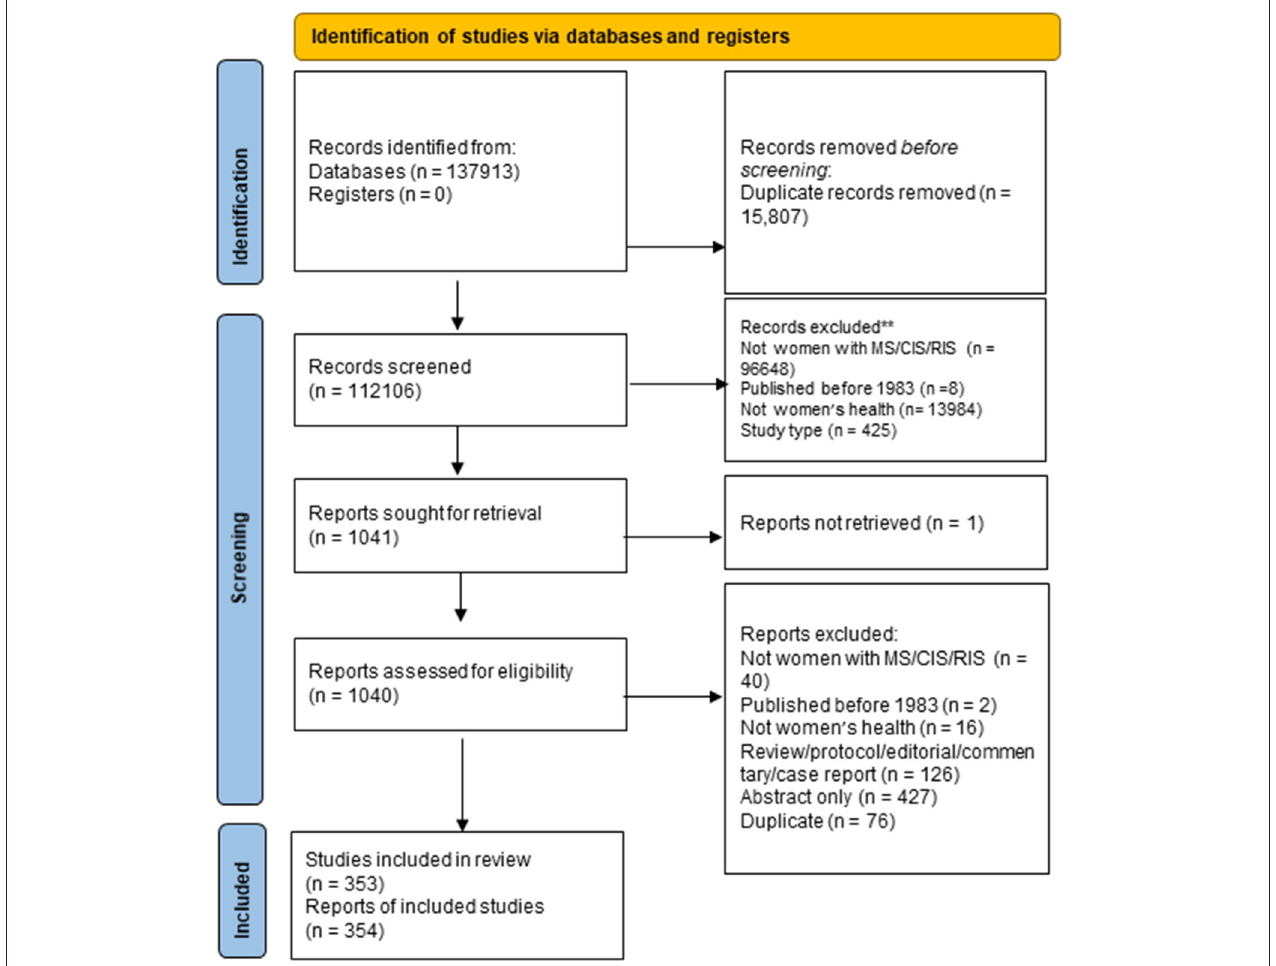
FIGURE 1 | PRISMA flow